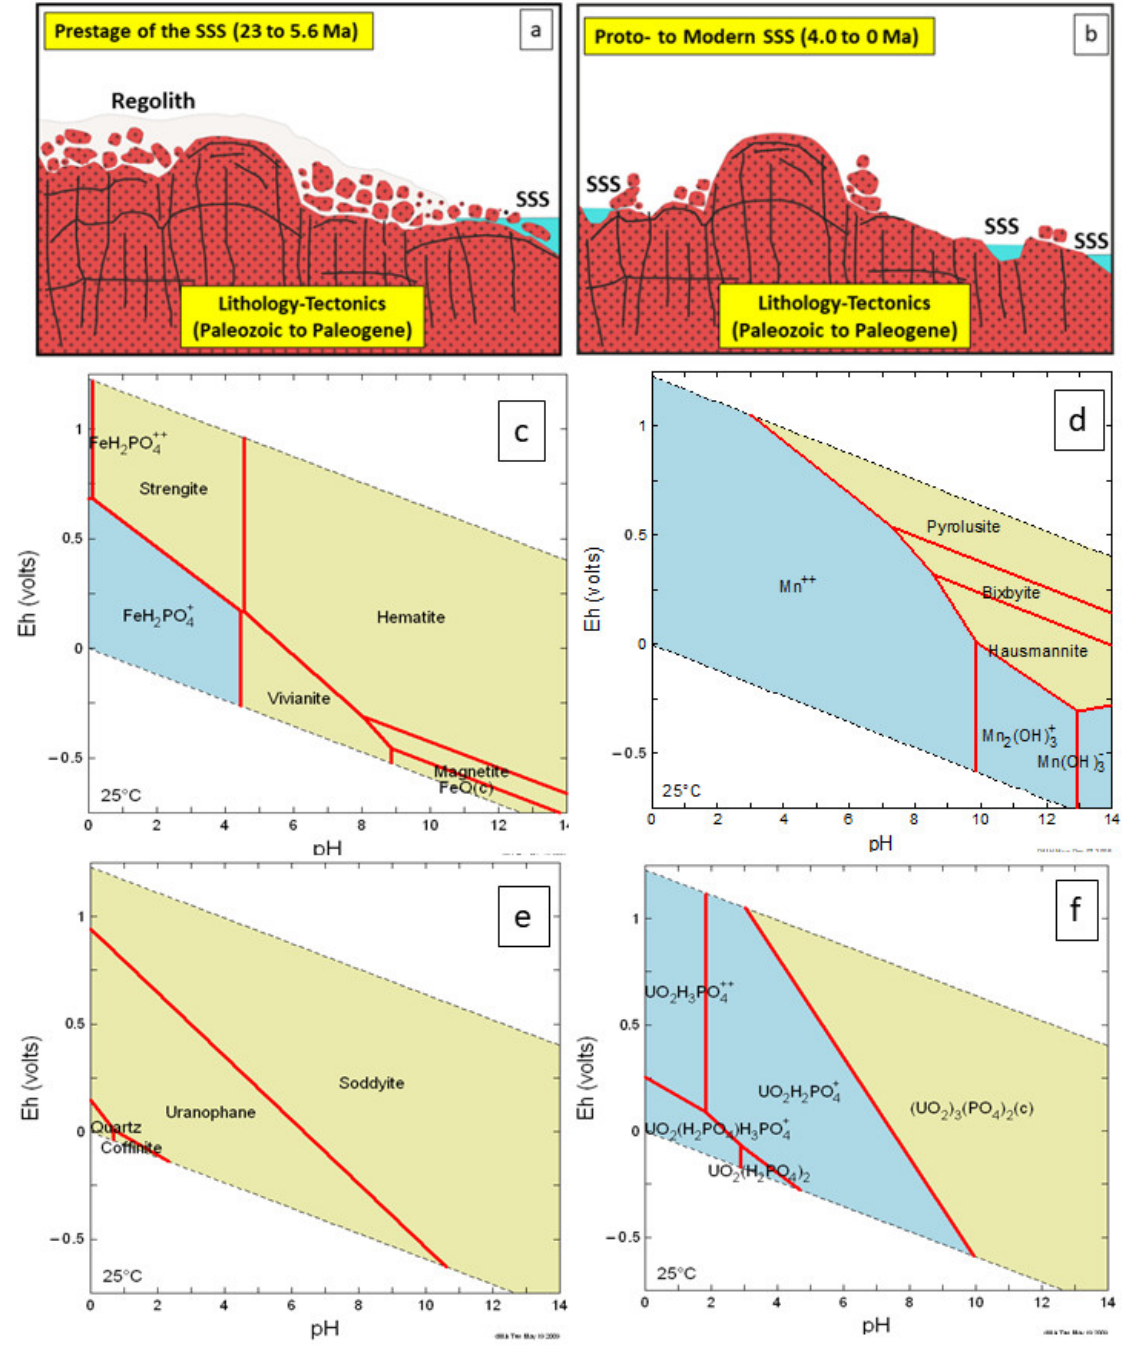
Figure 16. Cartoons to illustrate the stage-wise geomorphological evolution of the SSS during the Neogene and Quaternary which has been derived from a lithological and structural frame supplemented ( a , b ) with thermo-chemical calculations to bolster the chronological and climatic constraints of the succession of the SSS ( c – f ). Assumed concentrations of dissolved species are given below in mol/L. ( a ) Formation of supergene alteration surfaces (etch planation/surface, regolith) and encrustations (silcrete, phoscretes, ferricretes) defined by U-P-Si-Fe-Mn mineralizations as to the age of formation and the physical chemical regime. Onset of the formation of domal landforms, e.g., inselbergs, wide-and-shallow valleys formed by braided and meandering drainage systems. For calculations see ( c , d ); ( b ) Denudation of regolith and tor formation and fluvial incision of the SSS into exposed crystalline basement rocks. For calculations see ( d – f ).; ( c ) Eh-pH diagram to show the Fe-P mineralization at 25 ◦ C using the dissolved species as log aFe = − 3, log aHPO4 = − 5; ( d ) Eh-pH diagram to show the Mn mineralization at 25 ◦ C using the dissolved species as log aMn = − 6; ( e ) Eh-pH diagram to show the U-Si mineralization at 25 ◦ C using the dissolved species as log aU4+ = − 7, log aSiO2(aq) = -3, log a ca2+ = − 3; ( f ) Eh-pH diagram to show the U-P mineralization at 25 ◦ C using the dissolved species as log aU = − 7, log aHPO4 = −